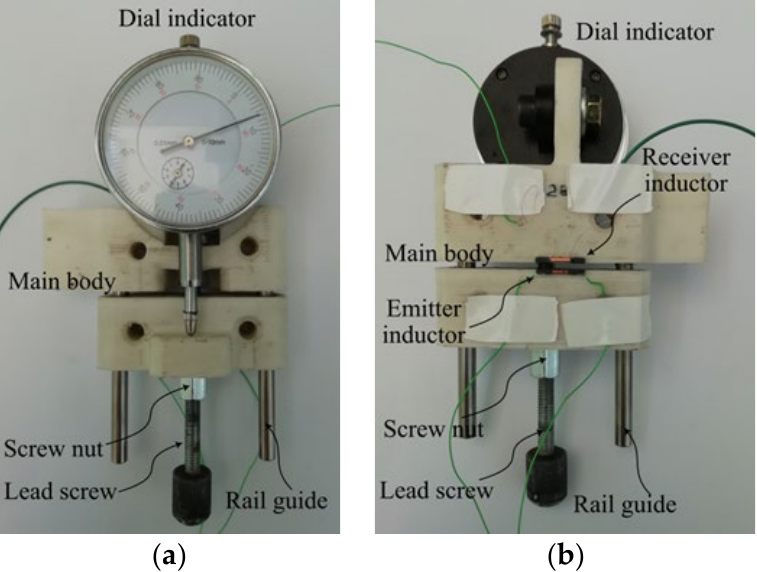
Figure 11. ( a ) Side A of the controlled gap mover apparatus; ( b ) side B of the controlled gap mover